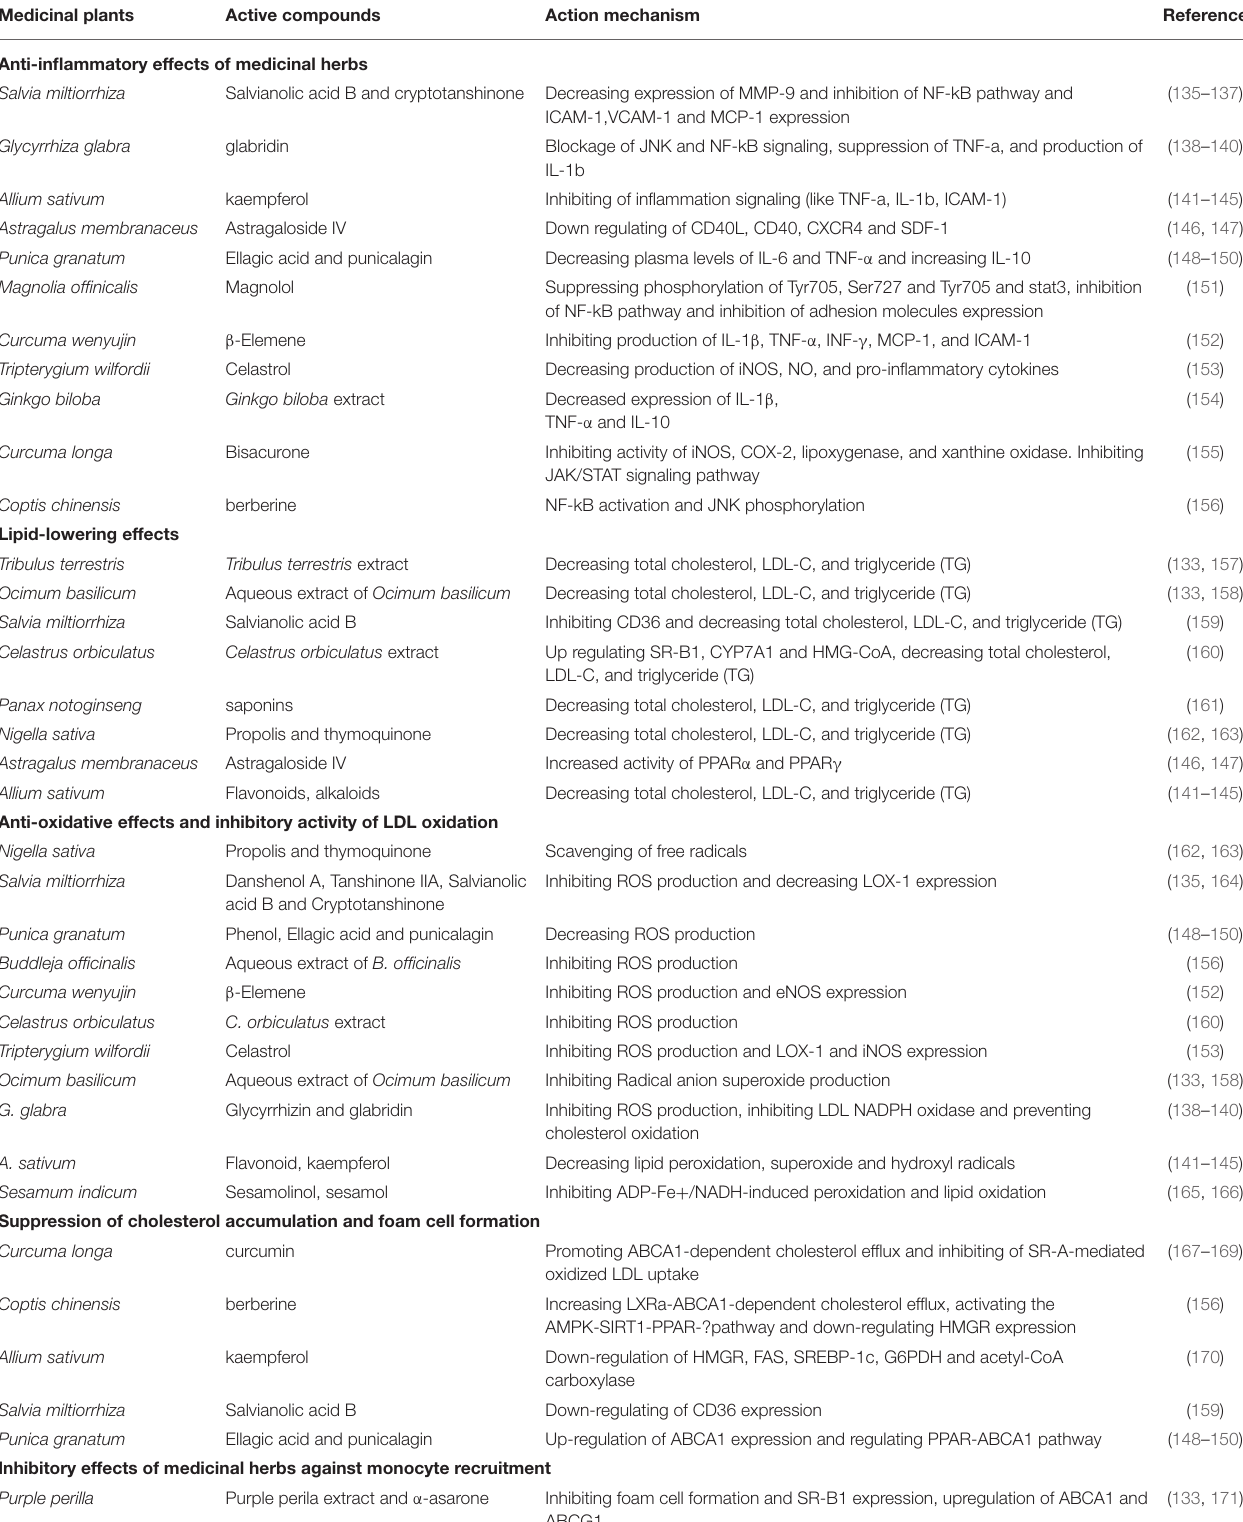
TABLE 3 | Important anti-atherosclerotic medicinal plants and